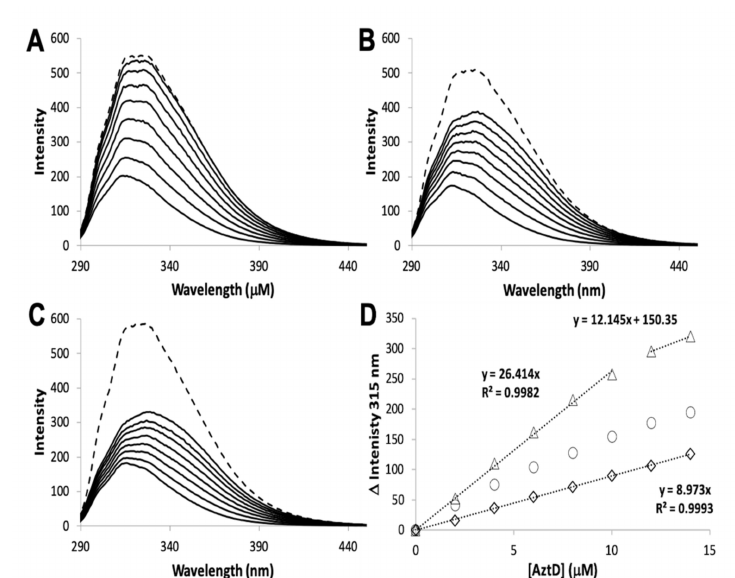
Figure 5. Zinc transfer by intrinsic fluorescence. Reconstituted WT AztD was titrated into apo WT ( A ), H138 / 204A ( B ), or ∆ D-Loop ( C ) AztC. Fluorescence emission spectra ( λ exc = 278 nm) were recorded